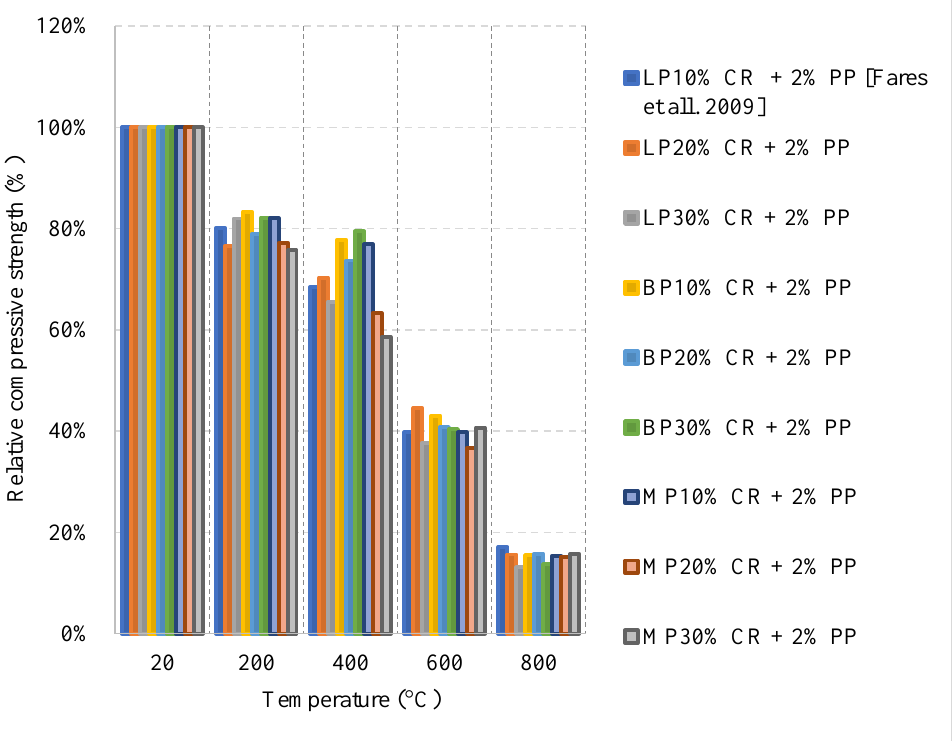
Table 6. Important parameters of different studies on HSC [75,101–108].